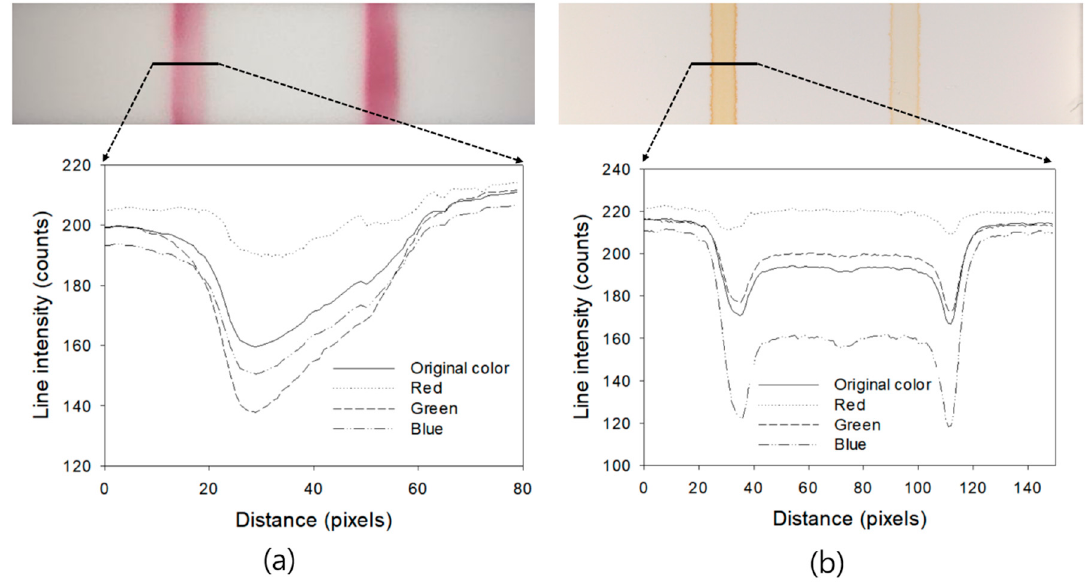
Figure 5. Comparison of the pixel intensity profiles of the original color, red, green, and blue images for an LFIA test line using gold nanoparticles ( a ) and iron oxide nanoparticles ( b ) as the labeling particles.